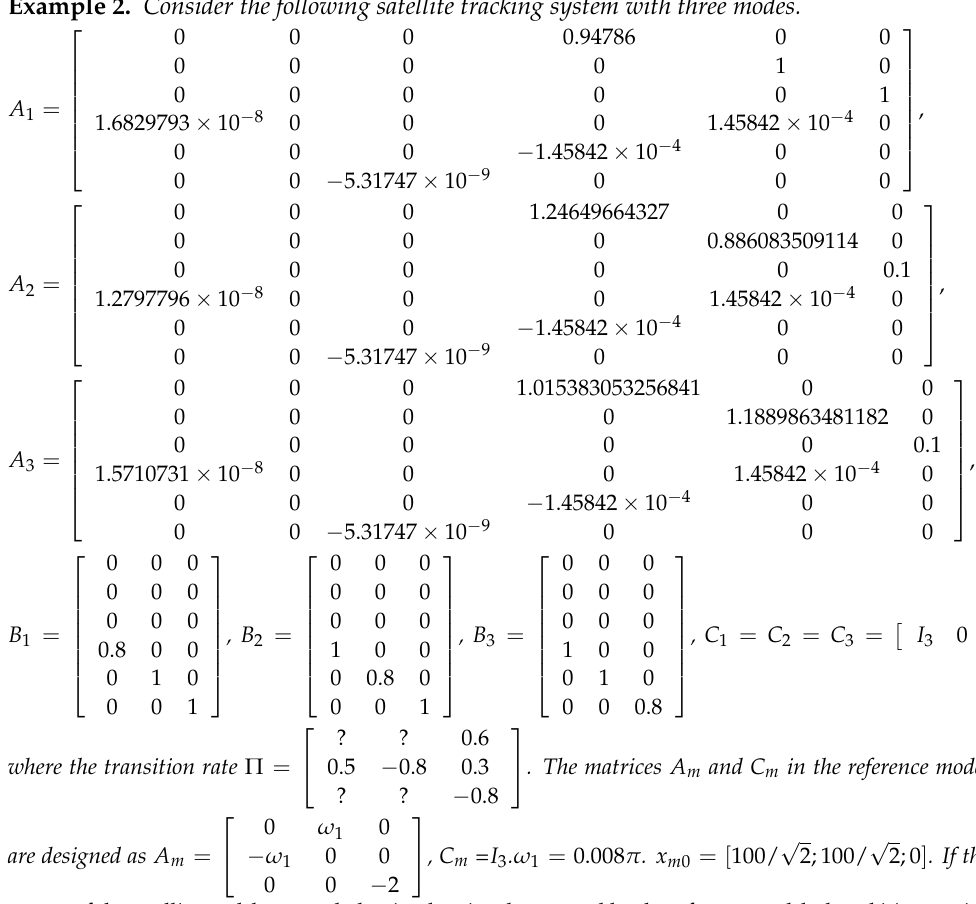
Figure 2. Results of the observer under initial conditions [ 1, − 2,1,0 ] . Example 2. Consider the following satellite tracking system with three